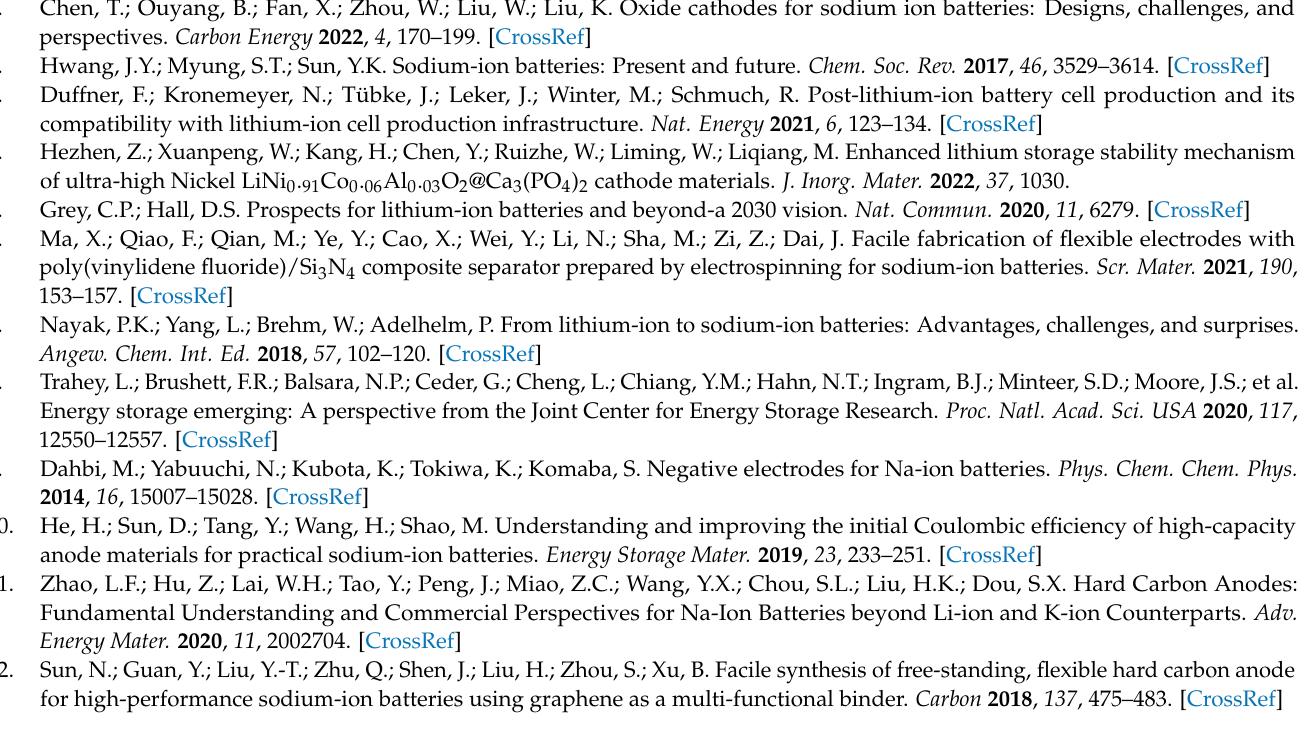
(b) VTO; Figure S2: XRD pattern of Ru-VTO precursor; Figure S3: (a) The contribution ratio of the capacitive capacities at 0.8 mV s − 1 for VTO. (b) CV curves of VTO at scan rates range from 0.1 to 1.0 mV s − 1 ; Figure S4: Potential response during GITT measurements at 20 mA g − 1 for (a) Ru-VTO and (b) VTO; Figure S5: Galvanostatic charge and discharge voltage profiles of (a) Ru-VTO and (b) VTO under different current densities; Figure S6: CV test result for the initial three cycles of Ru-VTO at 0.1 mV s − 1 ; Figure S7: EIS curves of Ru-VTO and VTO; Figure S8: Cycling performance at 50 mA g − 1 for TiO 2 , VTO and Ru-VTO; Figure S9: Cycling performance of Ru-doped samples with different concentrations at 50 mA g − 1 ; Figure S10: EIS of Ru-VTO after the galvanostatic tests; Figure S11: XPS spectra of O 1s for TiO 2 , VTO and Ru-VTO; Figure S12: Element mapping of Ru-VTO; Figure S13: The quantitative EDS analysis for Ru-VTO; Equation (S1): Scherrer equation; Table S1: Elemental content analysis of XPS for